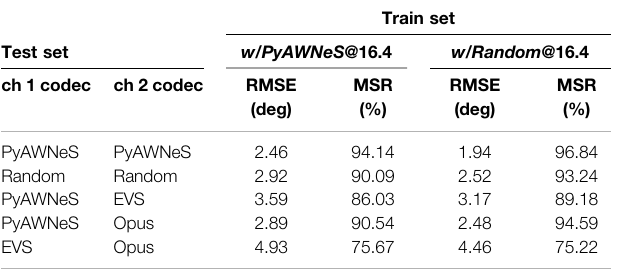
TABLE 4 | Performance of models: trained with PyAWNeS at 16.4 kB/s ( w / PyAWNeS@ 16.4), and trained on randomly selected codec ( w /